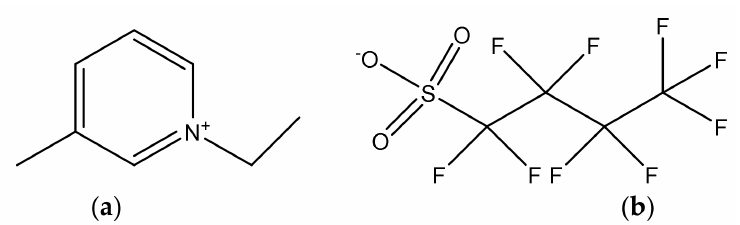
Figure 1. Molecular structure of 1-ethyl-3-methylpyridinium perfluorobutanesulfonate, [C 2 C 1 py] [C 4 F 9 SO 3 ]. ( a ) Cation 1-ethyl-3-methylpyridinium; ( b ) Anion perfluorobutanesulfonate.